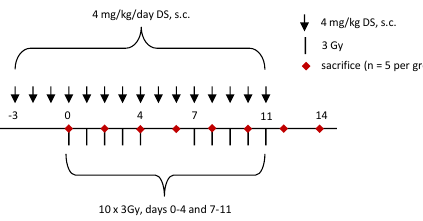
Figure 5. Experimental design. Daily fractionated irradiation was given in 10 fractions with 3 Gy per day over two weeks, including an irradiation-free weekend (days 5 and 6). Irradiation was either applied alone (group: IR) or in combination with daily 4 mg/kg dermatan sulfate (DS) treatment from day-3 before the start of irradiation (day 0) until sacrifice (group: IR + DS). 5 animals per experimental group were sacrificed in two days